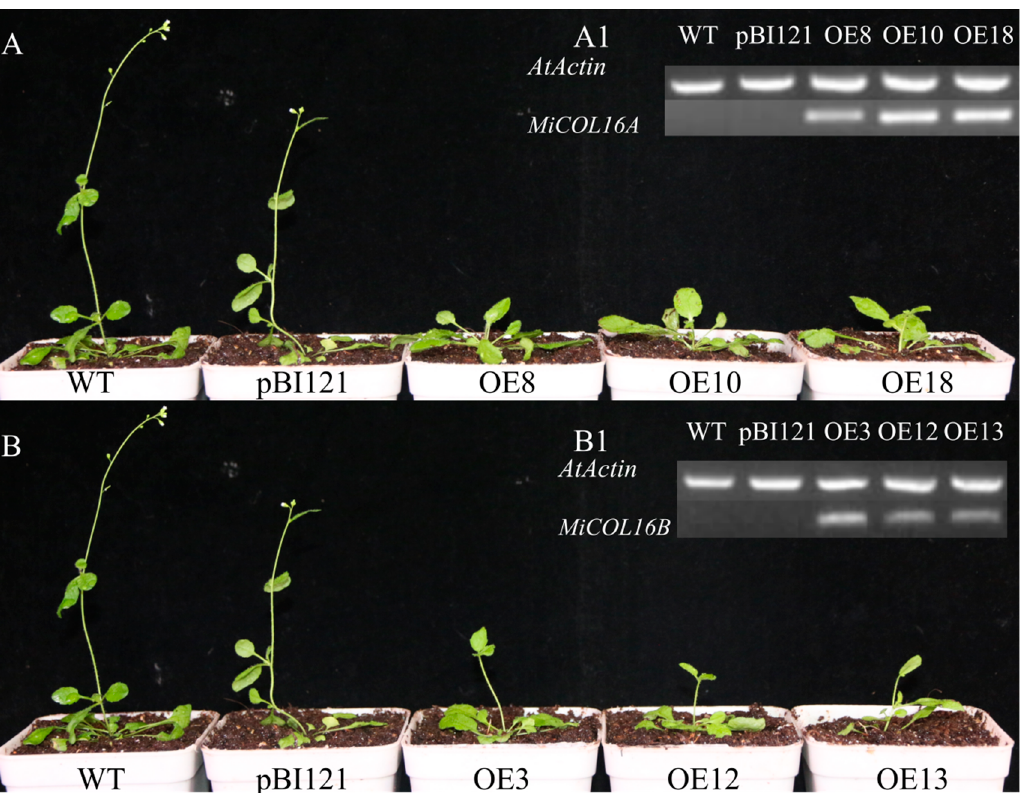
Figure 6. Ectopic expression of MiCOL16A and MiCOL16B delayed flowering under SD conditions. ( A1 , B1 ) Expression of MiCOL16A ( A1 ) and MiCOL16B ( B1 ) in the WT, empty vector-transformed and overexpression plants. ( A ) MiCOL16A transgenic Arabidopsis plants under SD conditions. ( B ) MiCOL16B transgenic Arabidopsis plants under SD conditions.